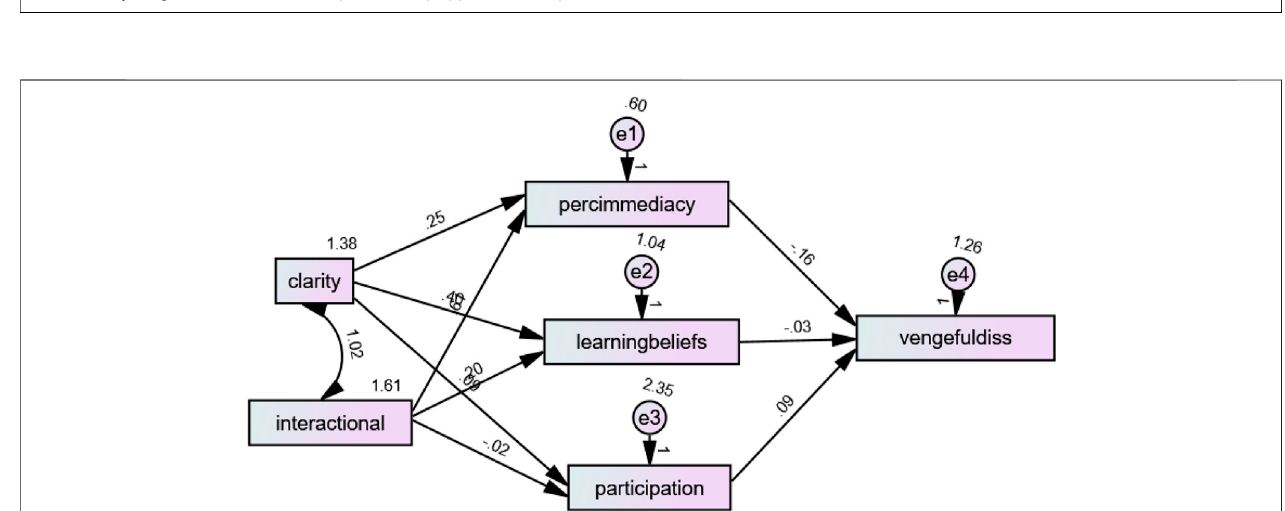
FIGURE 7 | Vengeful dissent without class preference (Supported model).